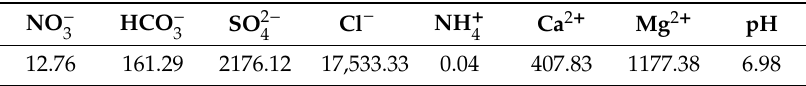
Figure 6. Compressive strength of concrete at different curing ages. Table 4. Composition of seawater (mg/L).